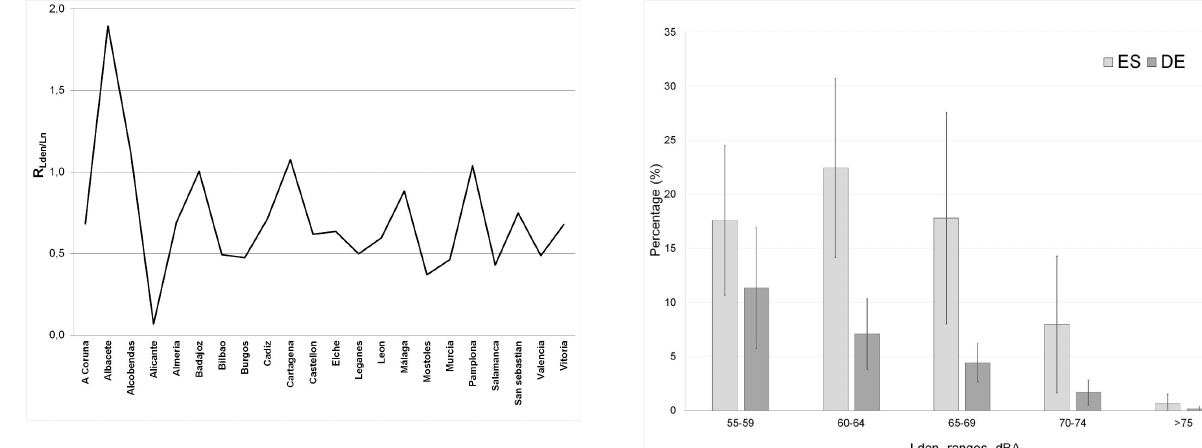
Figure 6: The R Lden / Ln = ( L d > 65) /( L n > 55 ) ratio for each Spanish agglomeration.